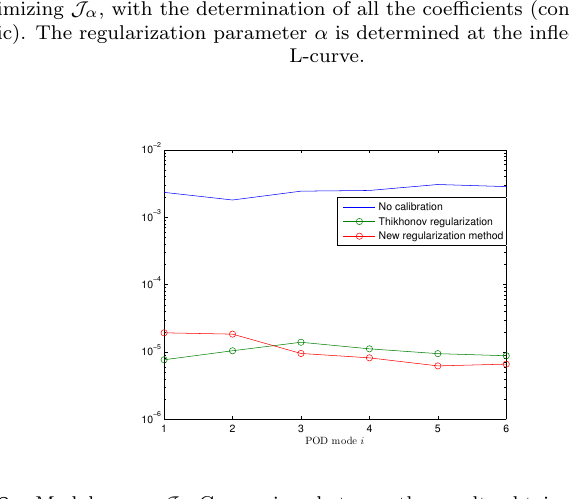
Figure 8. Modal errors J i . Comparison between the results obtained by the proposed approach and those determined with the calibration technique based on Tikhonov regularization developed in